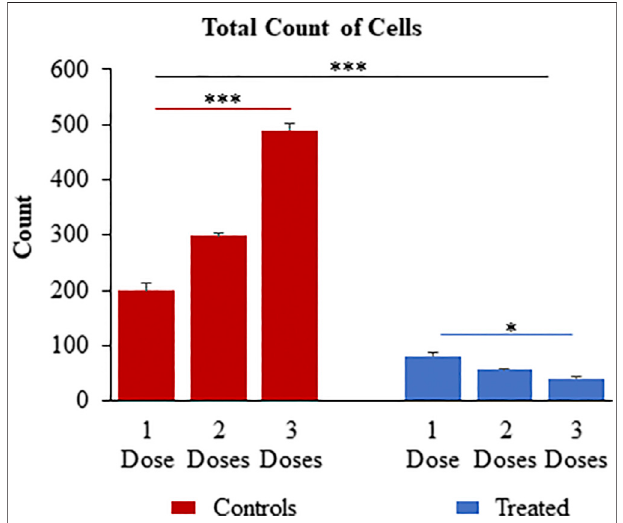
FIGURE 9 | Successive treatment of CuHARS (10 μ g/ml) on CRL-2303 glioma cells plated at 3,000 cells per ml at an interval of every 24 h up to three doses showing signi fi cant increase in toxicity on the glioma cells with increase in number of treatments as represented by the DAPI image analysis results for total count of cells. Red bars on left of panel are control wells and blue bars represent wells treated with CuHARS. Data represent average over threeexperiments( N (cid:2) 3)withtriplicatedwells( n (cid:2) 3).Theerrorbarsrepresent SEM values, “ *** ” represent p < 0.001 and “ * ” represent p < 0.05.